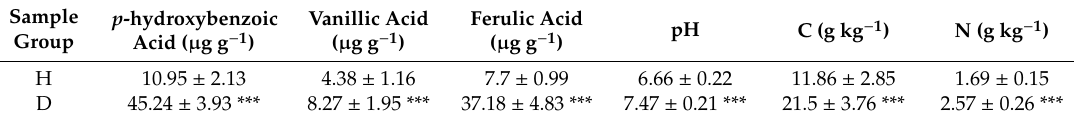
Table 2. Environmental factors of healthy (H) and wilt-diseased (D) tomato plant rhizosphere samples. Sample